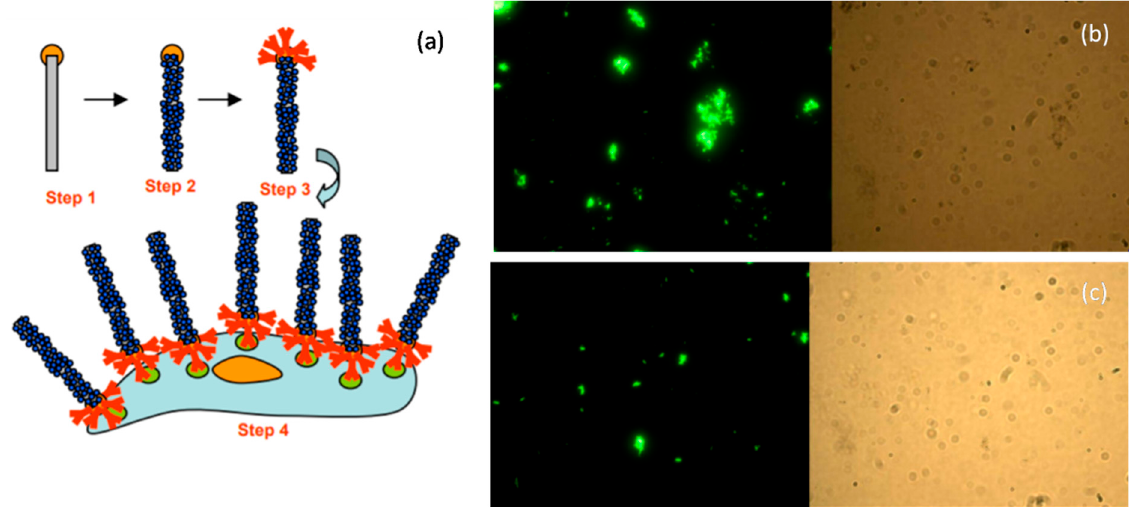
Figure 13. ( a ) Step-by-step process for Salmonella detection using Au/Si rods comprising nanorod fabrication, dye immobilization, antibody conjugation, and bacteria detection through antigen–antibody conjugation, respectively. Fluorescence microscopic images with BSA blocking under fluorescent light and white light for ( b ) anti-salmonella/Au/Si nanorods and fixed salmonella and ( c ) Au/Si nanorods and fixed salmonella. Reproduced with permission from [172].